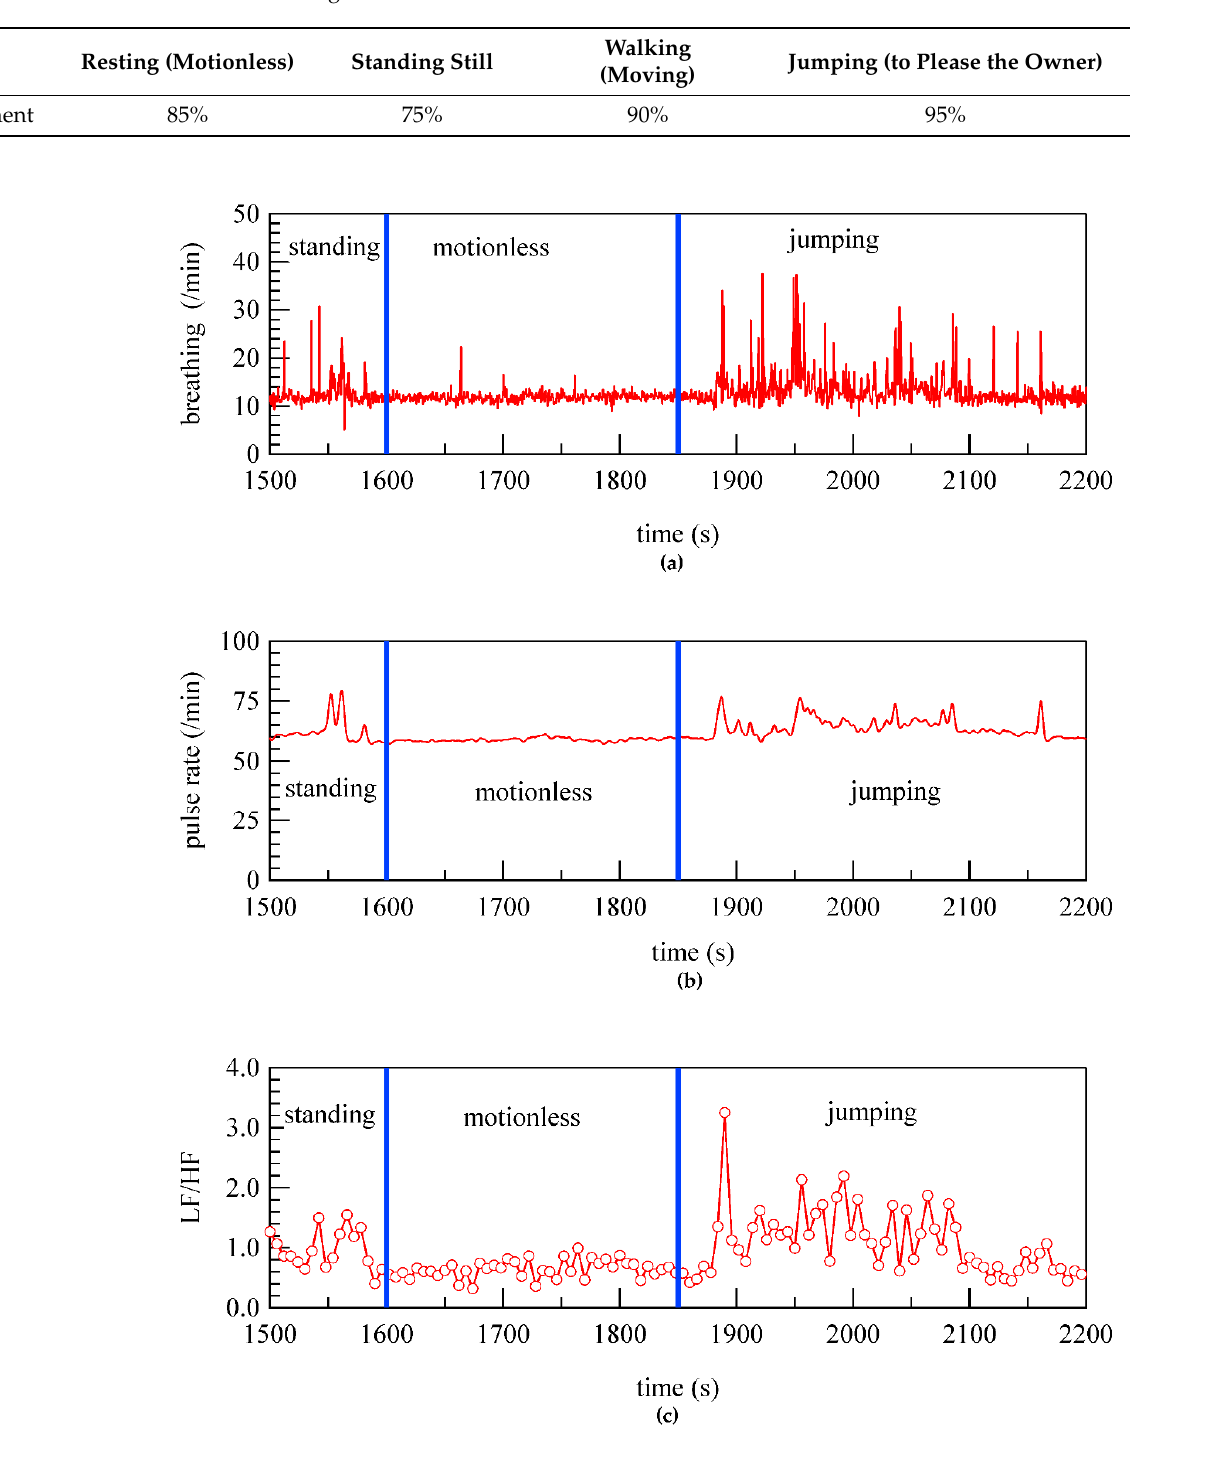
Table 3. Rate of agreement between the judgment result from the signal from the piezoelectric blade and the video image.